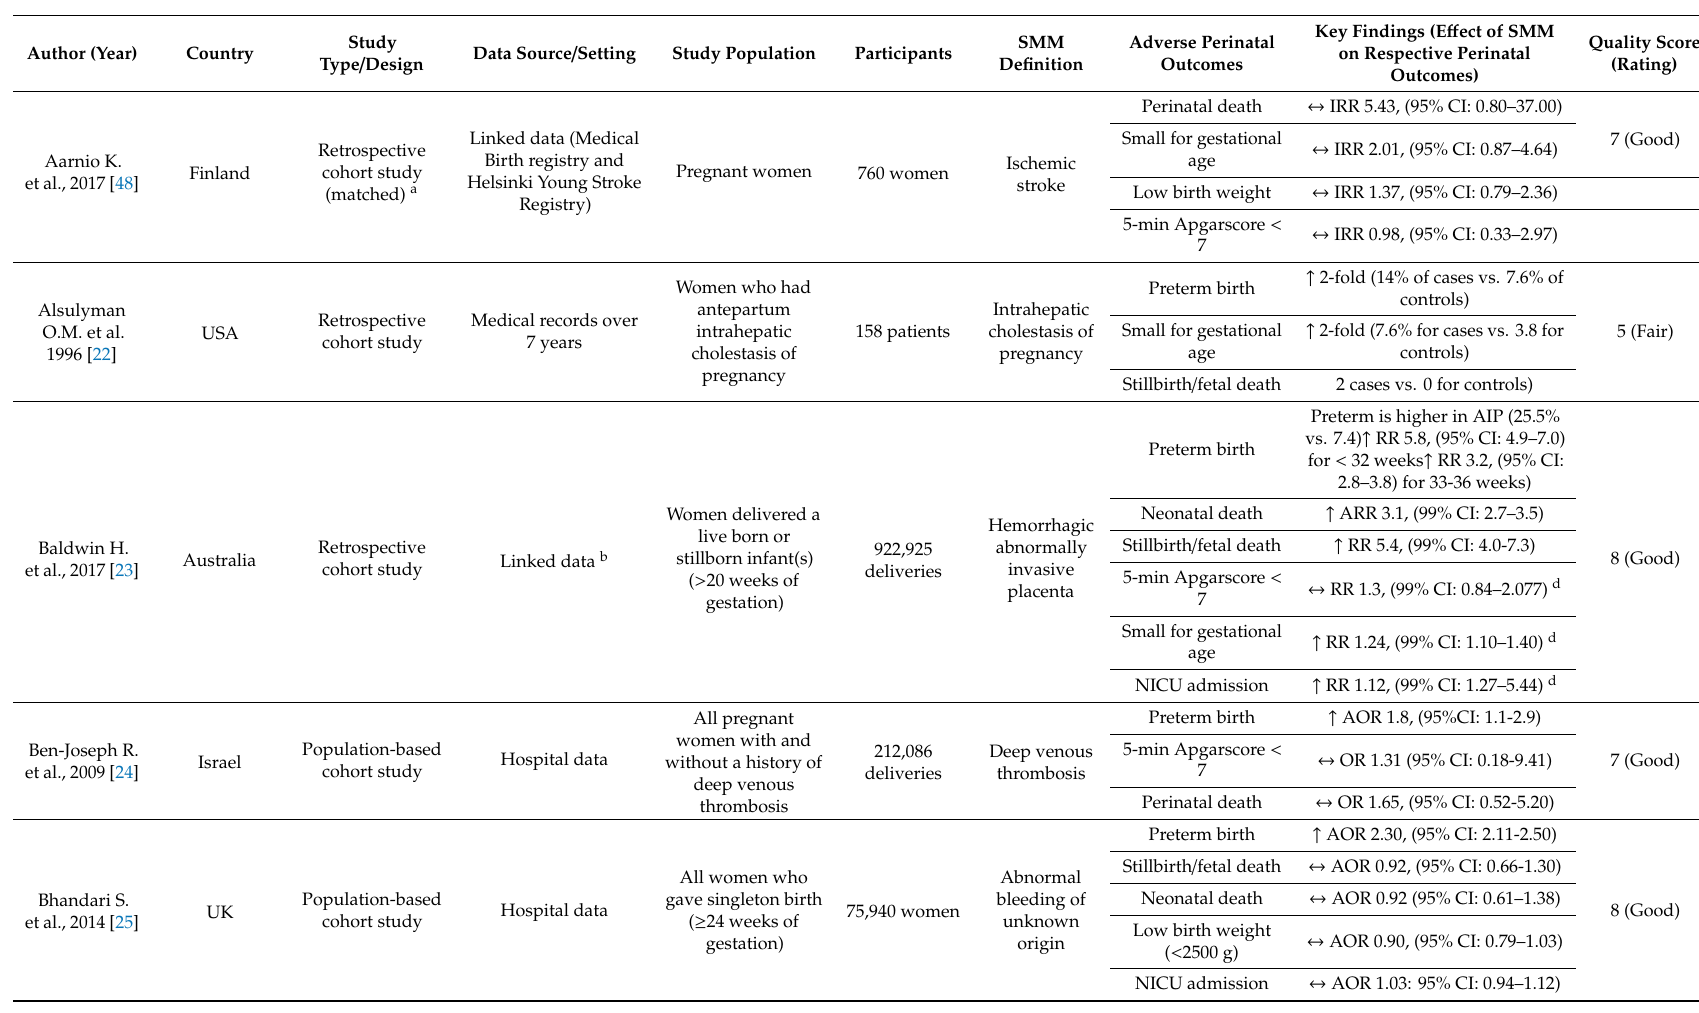
Table 2. Detailed characteristics of included studies and quality